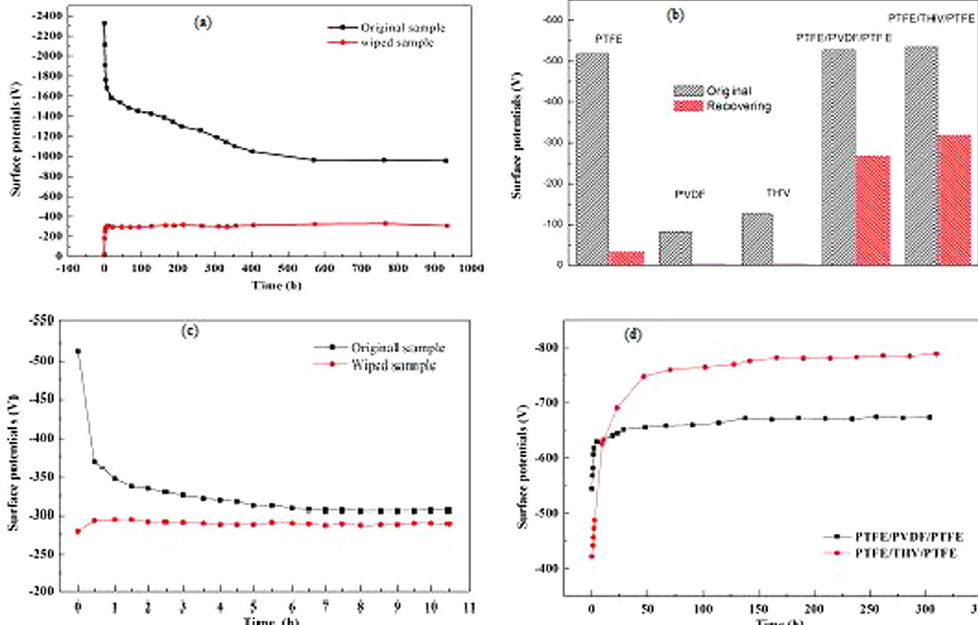
Figure 5. Supplementary experimental results (different charging methods, comparison with single layers and sandwiched layers, different middle layers). (a) V S of the original and wiped PTFE/THV/PTFE as a function of storage time by corona charging method; (b) V S self-recovery performance for single layer (PTFE, PVDF, THV) and sandwich membrane (PTFE/PVDF/PTFE, PTFE/THV/PTFE). Grey column: original state; Red column: recovering state after wiping sample surface with alcohol and storing in atmosphere for 24 hours; (c) V S of the original and wiped PTFE/THV/PTFE as a function of storage time at storage temperature 100 °C by thermal charging method; (d) V S of the sandwich membrane with different middle layers PVDF and THV as a function of storage